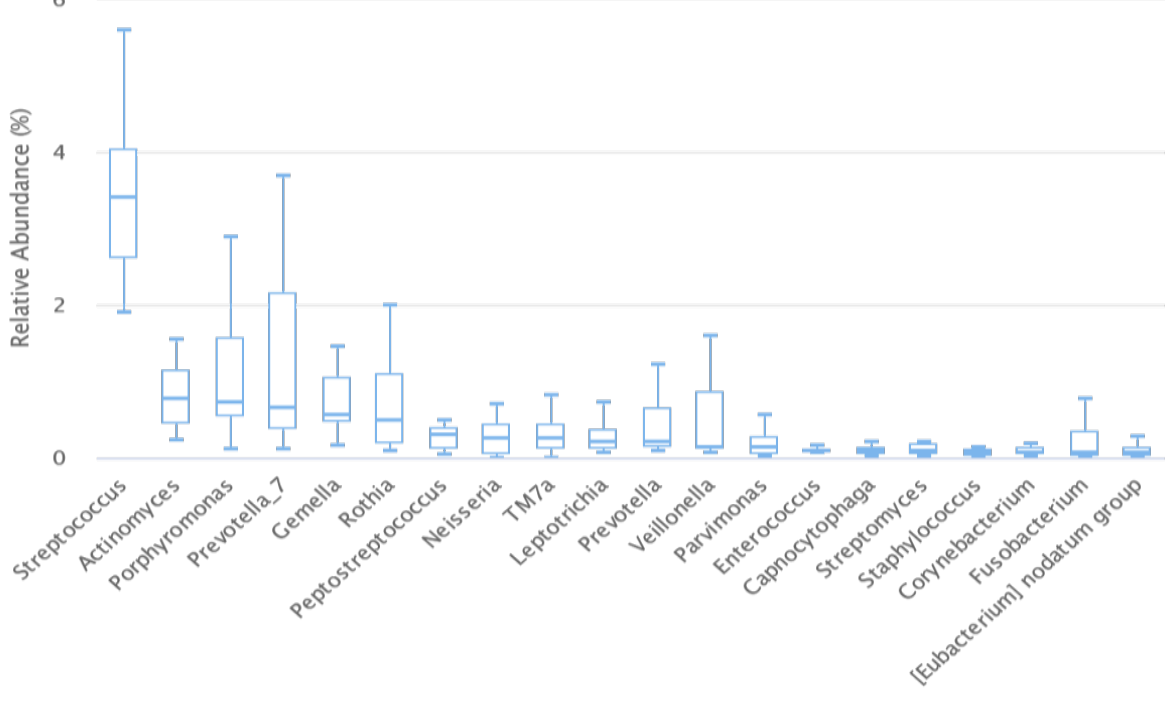
Figure 3. Distribution of dominant genera in saliva samples of all participants.